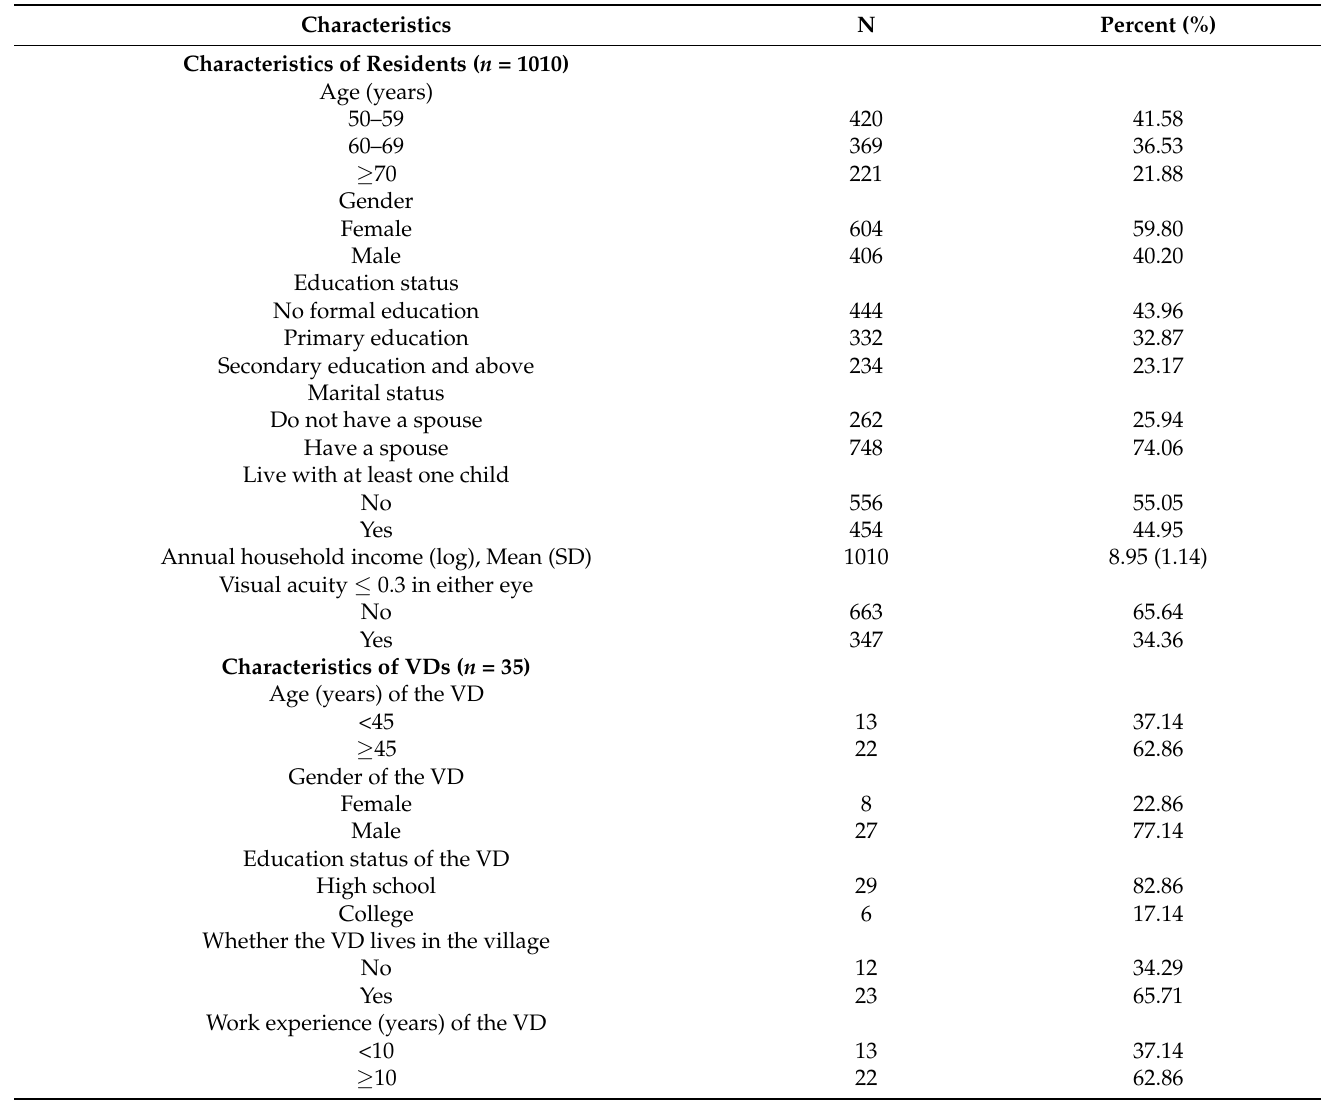
Table 1. Demographic characteristics of